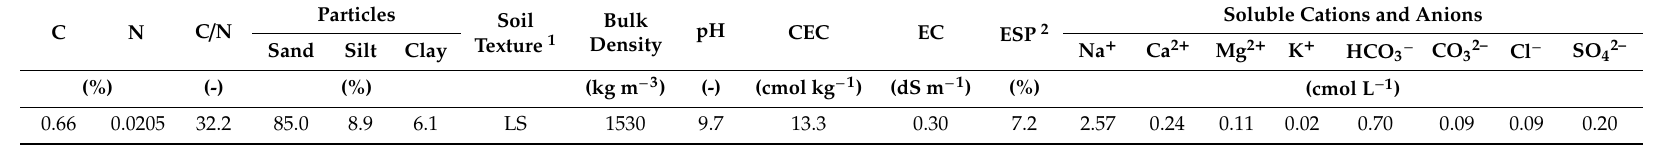
Table 3. Soil carbon and nitrogen content, and the physicochemical properties of untreated soil.